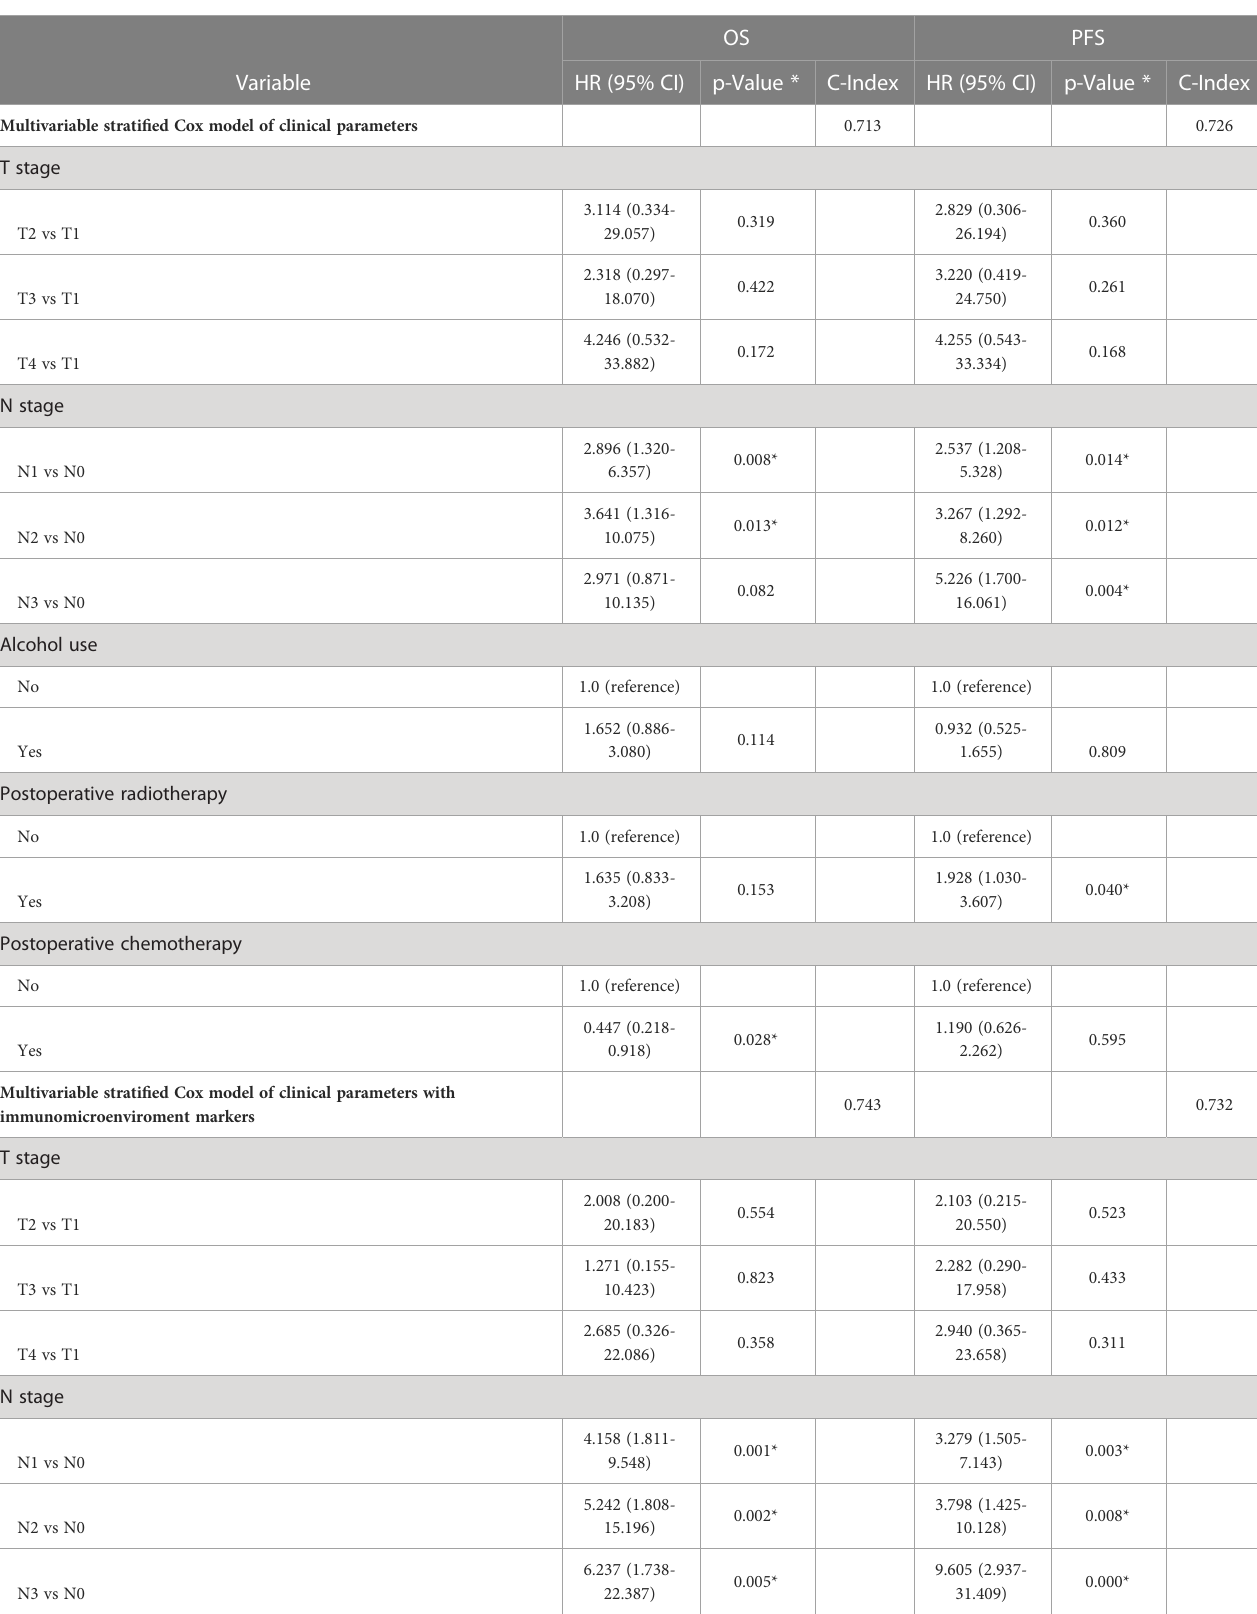
TABLE 3 Multivariate Cox regression